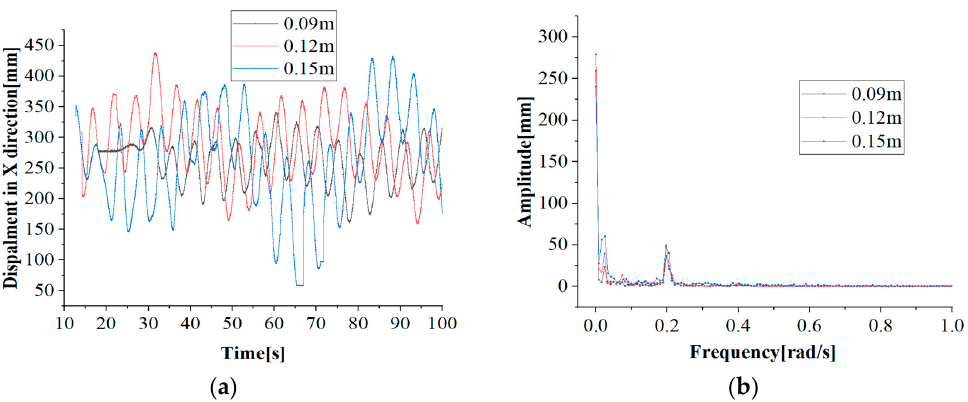
Figure 13. Surge response of the pedestal with different wave heights at 0.20 Hz. ( a ) Surge; ( b ) surge frequency domain curve.